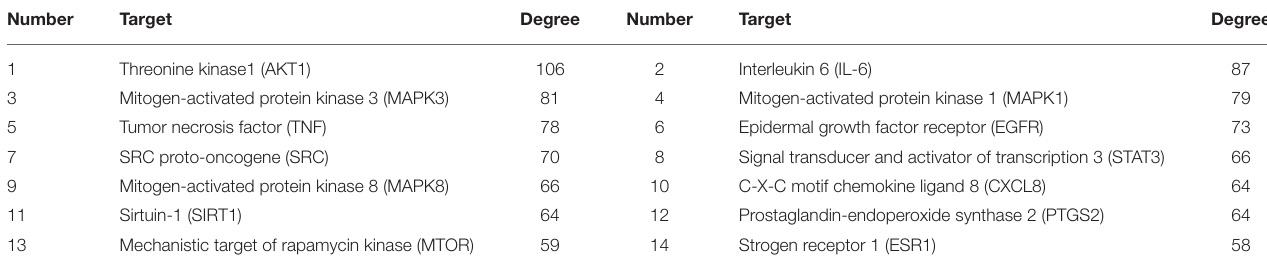
TABLE 3 | Key targets of AS antioxidant PPI